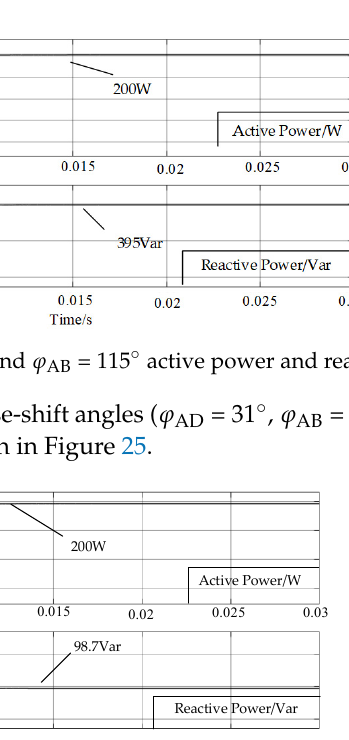
Figure 25. φ AD = 31° and φ AB = 80.2° active power and reactive power waveforms. From the above simulation results, it can be seen that the reactive power value of the obtained phase-shift angle is significantly smaller than other combinations of phase-shift angles under the premise of achieving full-bridge arm ZVS. Although the obtained points may be located near the boundary of the A-bridge arm or B-bridge arm, the obtained results are located within the ZVS range, and the value of the reactive power is greatly reduced, which improves the overall efficiency of the system. When the gain M = 0.8, the combination of phase-shift angles output from the flow chart is brought into the simulation, and the combination of phase-shift angles is (92°, 239°), the simulation results of the active and reactive power obtained are as shown in Figure 26.